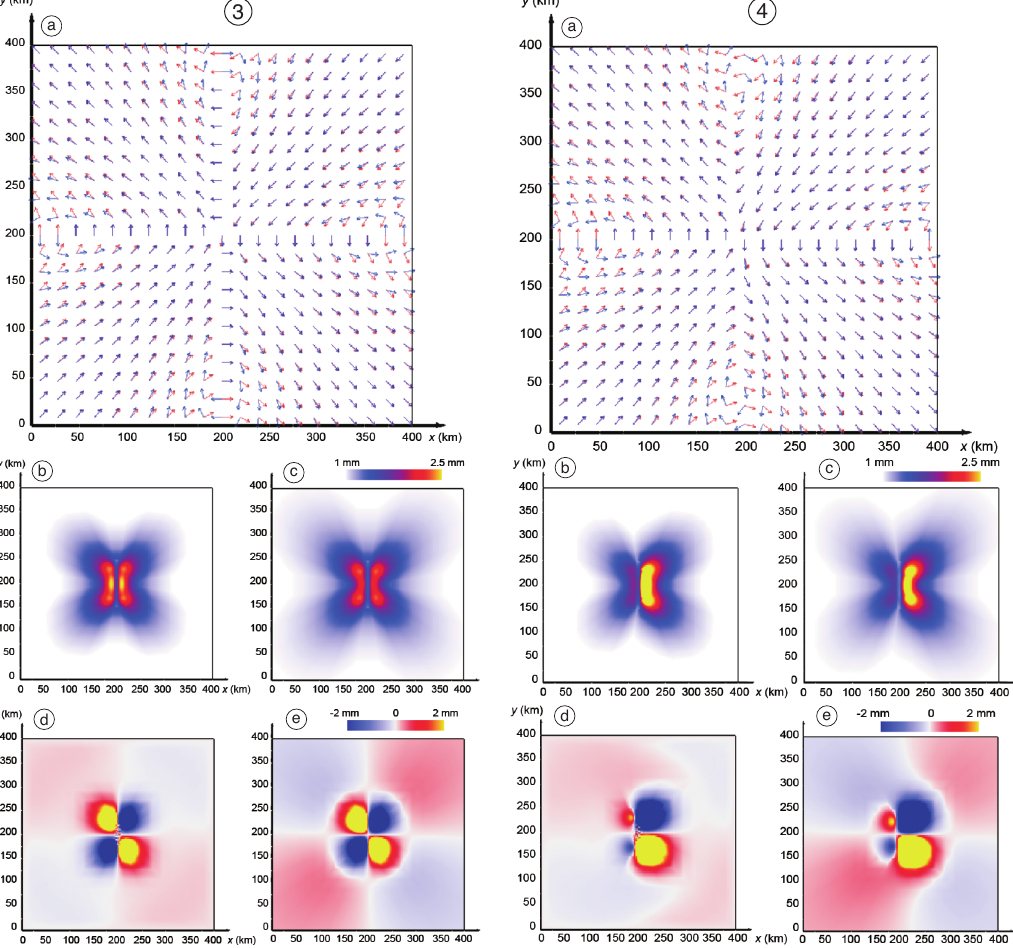
Fig. 3a-e. Ground displacement field for a right-lateral strike slip with dip δ = 90° and strike φ = 0° when the the bottom and lateral nodes are fixed. Horizontal displacement field (on the left ): a) numerical and analytical results are displayed simultaneously as a vector plot (blue arrows: numerical solution; red arrows: analytical so- lution); b) numerical and c) analytical solutions are displayed as color plots. Vertical displacement field (on the right ): d) numerical and e) analytical solutions are displayed as color plots. Fig. 4a-e. Same as fig. 3a-e but for a right-lateral strike slip with δ = 60° and φ = 0° when the the bottom and lateral nodes are